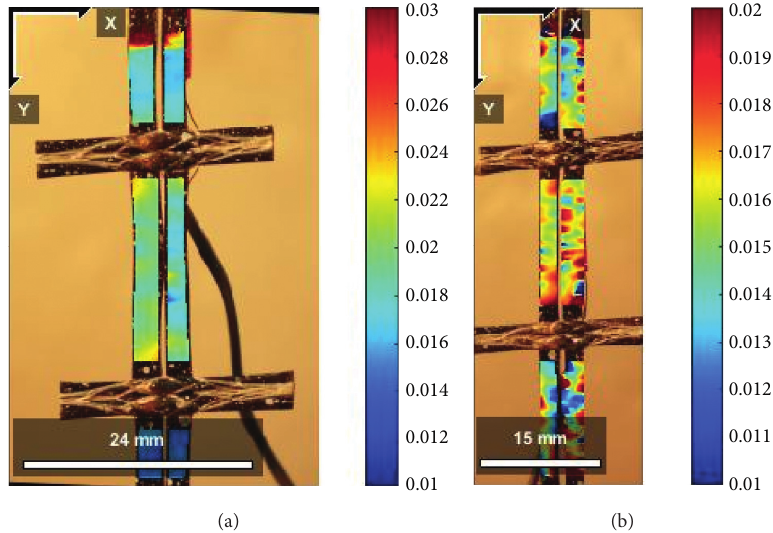
Figure 6: Vertical strain result of BFRP grids at their ultimate load. (a) BFRP-1. (b) BFRP-2.